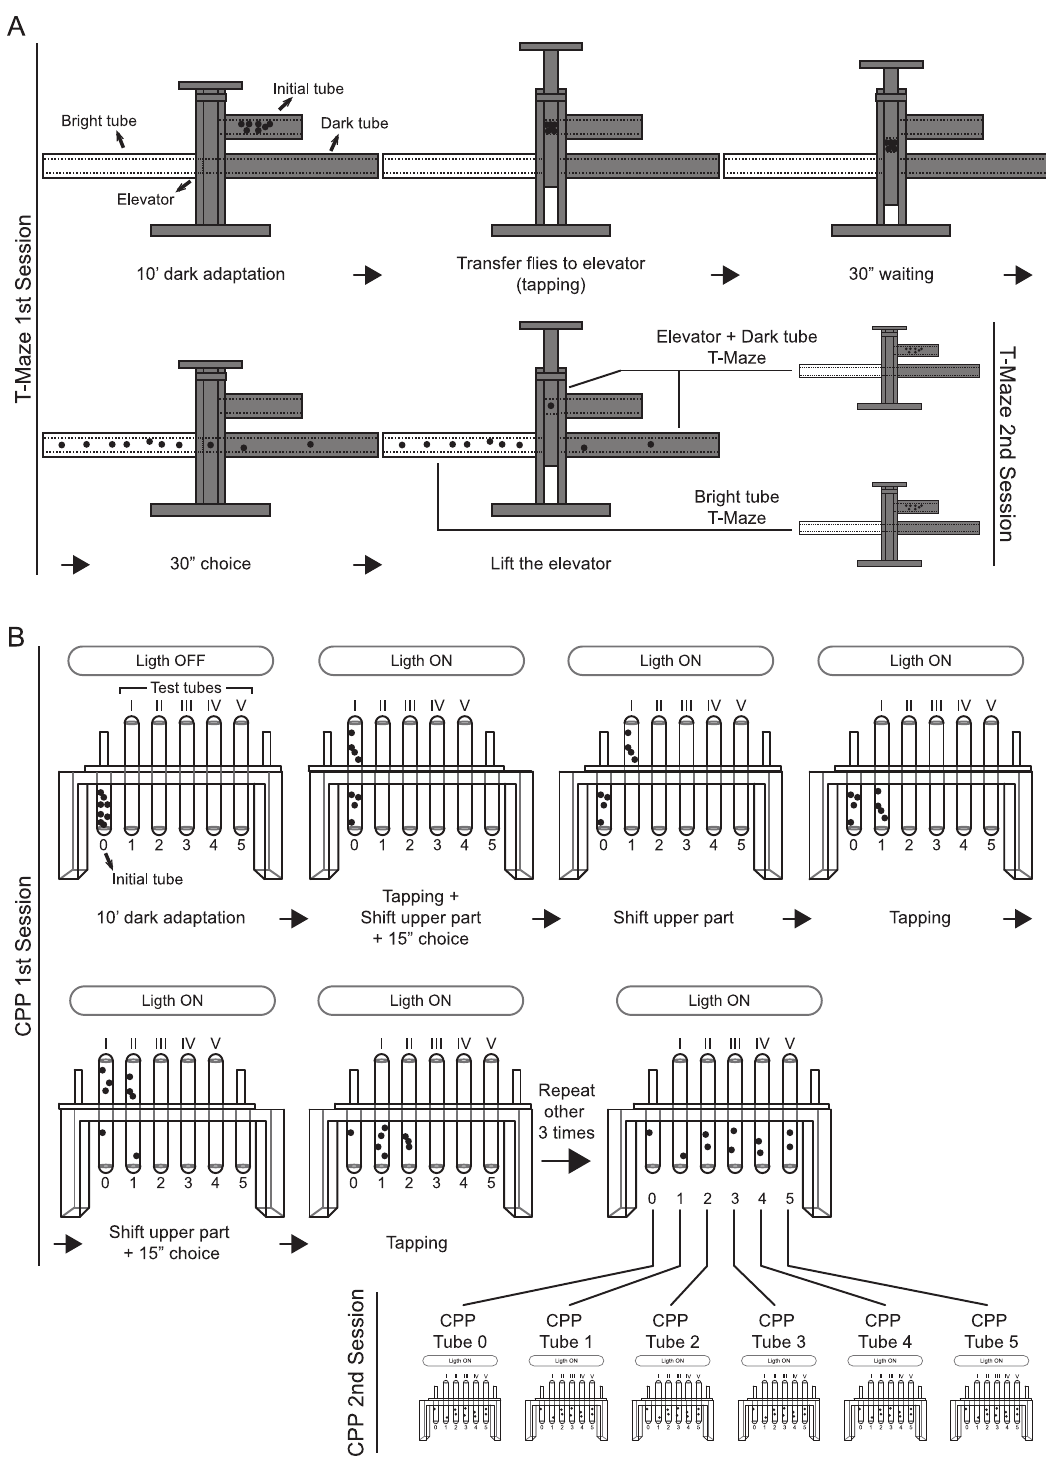
Fig 1. Schematics of paradigms and experimental design. Depiction of the first and second session of T-Maze experiments (A) and CPP experiments (B) . The drawings show a single replicate for each first session. Sometimes, flies from different replicates were added to reach the minimum amount of flies required for a second session. This was especially the case for Elevator+Dark Tube in the T-Maze (A) , and Tubes 0, 1 and 2 in the CPP (B) .